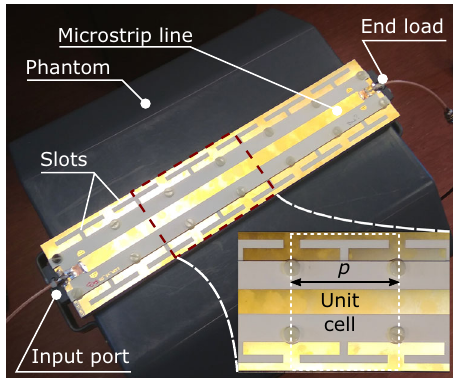
Fig. 8 Constructed protype of leaky-wave antenna. Photograps of the fabricated prototype of the optimized LWA placed over a pelvis-shaped homogeneous phantom for MRI